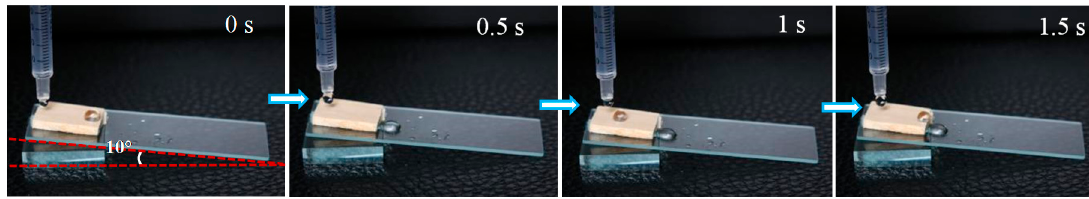
Figure 12. The dynamic SA test of PDMS@wood.